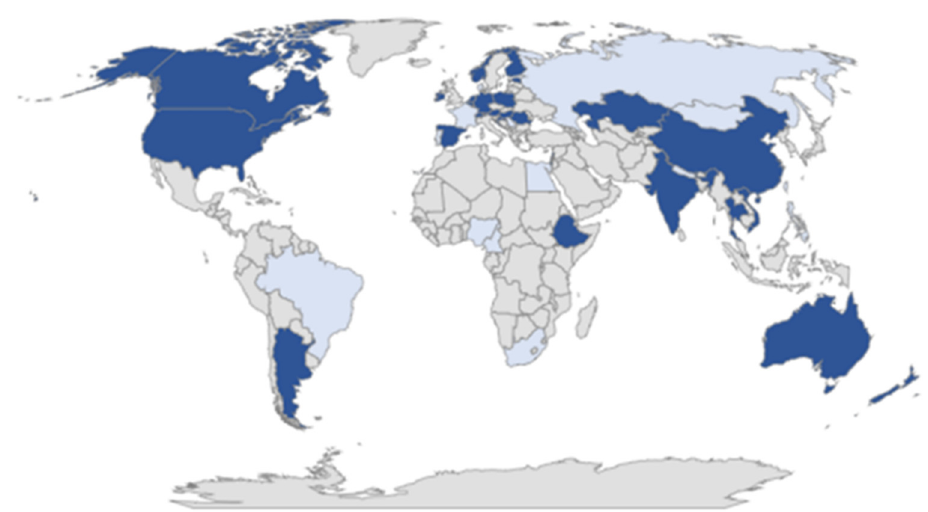
Figure 1. Included (dark blue) and excluded (bright blue) countries for sample analysis: Experts from the following countries were included: Australia (3× (AUS), Austria (AUT), Argentina (ARG), Belgium (BEL), Canada (3×) (CAN), China (CHN), Croatia (HRV), Estonia (EST), Ethiopia (ETH), Finland (FIN), Germany (2×) (GER), Hong Kong (HKG), Hungary (2×) (HUN), India (IND), Ireland (IRL), Israel (ISR), Kazakhstan (KAZ), Lebanon (LBN), Malta (MLT), Netherlands (NLD), New Zealand (NZL), Norway (2×) (NOR), Poland (POL), Romania (ROU), Spain (ESP), Switzerland (3×) (CHE), Thailand (THA), United Kingdom—England (2×) (GB), United Kingdom—Northern Ireland (NIR), United Kingdom—Scotland (SCO), United States (7×) (USA), and Vietnam (VNM). Experts from the following countries were excluded: Brazil, Denmark, Egypt, France, Mongolia, Nepal, Nigeria/Cameroon (both in one interview), Philippines, Portugal, Russia, Serbia, South Africa, and Taiwan.